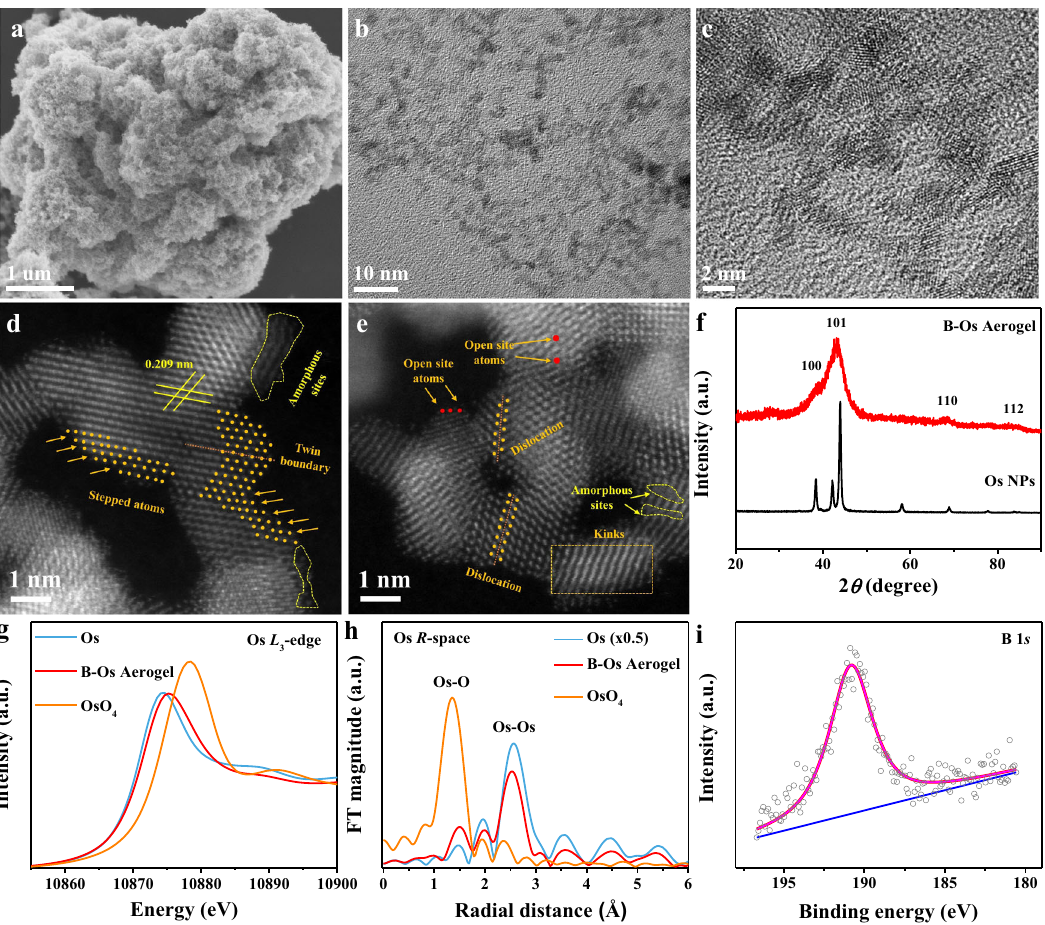
Fig. 1 Morphological and structure analysis of B-Os aerogels. a SEM; b , c HRTEM; d , e ACTEM images of B-Os aerogels. f XRD patterns of B-Os aerogels and Os NPs. g Os L 3 -edge XANES spectrum of B-Os aerogels with reference metallic Os and OsO 4 . h Fourier transformation of the EXAFS spectra of B-Os aerogels with reference metallic Os and OsO 4 . i Boron XPS